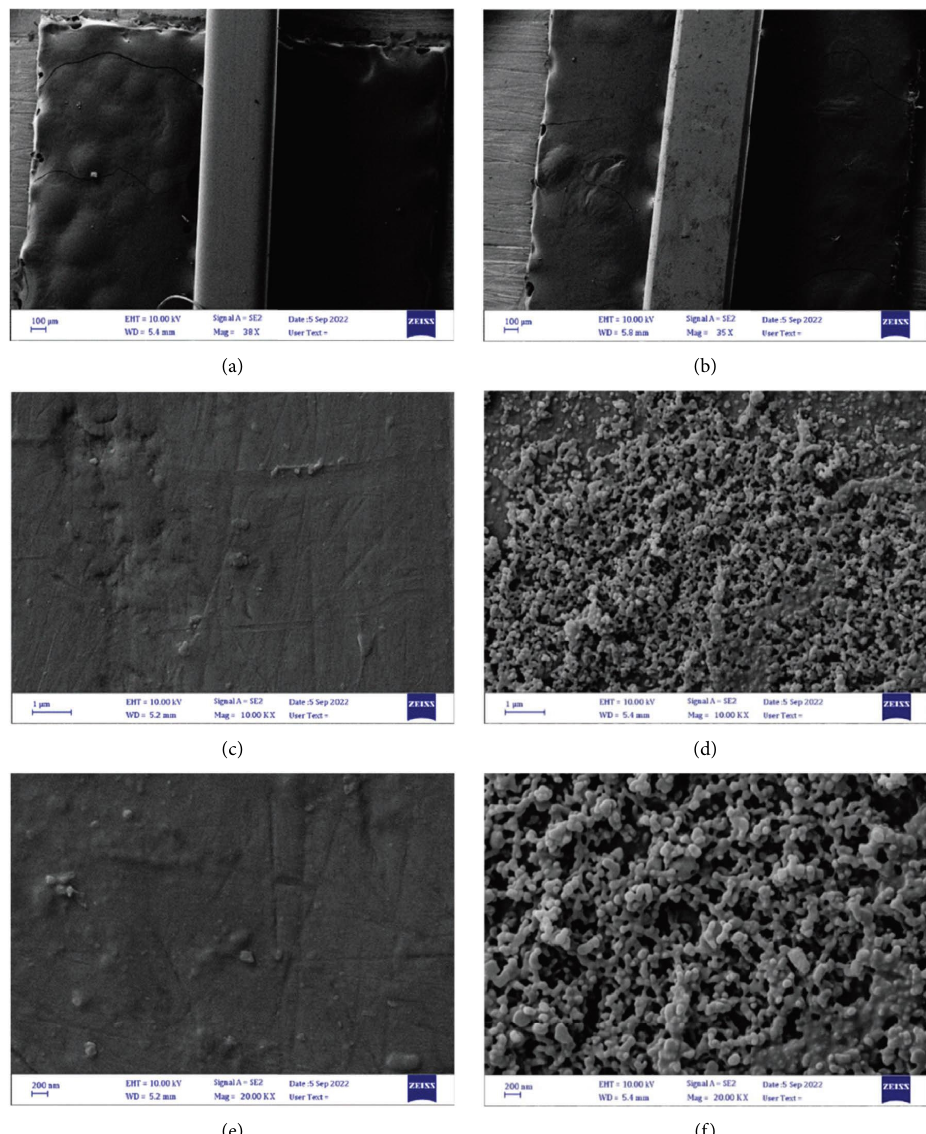
Figure 9: FeSEM images for the examined NiTiW at diferent magnifcation powers: (a, c, e) uncoated and (b, d, f)